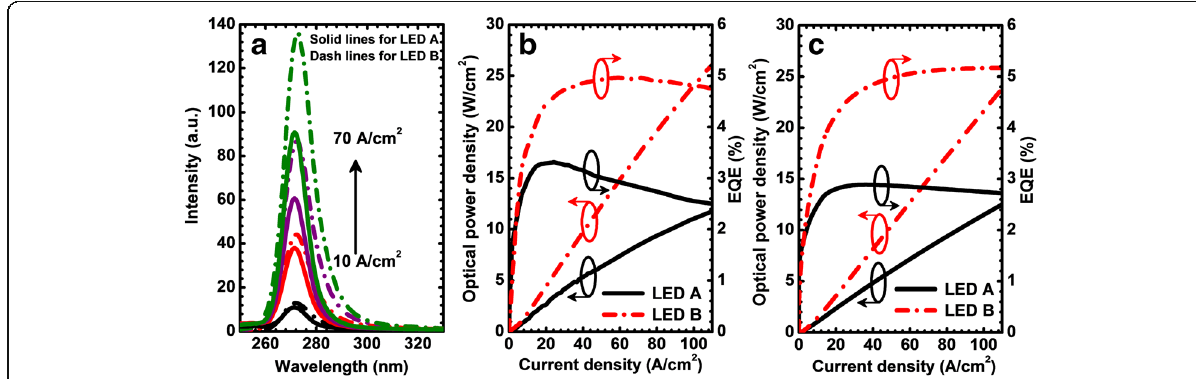
Fig. 2 a Measured EL spectra at the current density of 10, 30, 50, and 70 A/cm 2 . b Measured optical power and EQE. c Calculated optical power and EQE for LEDs A and B,